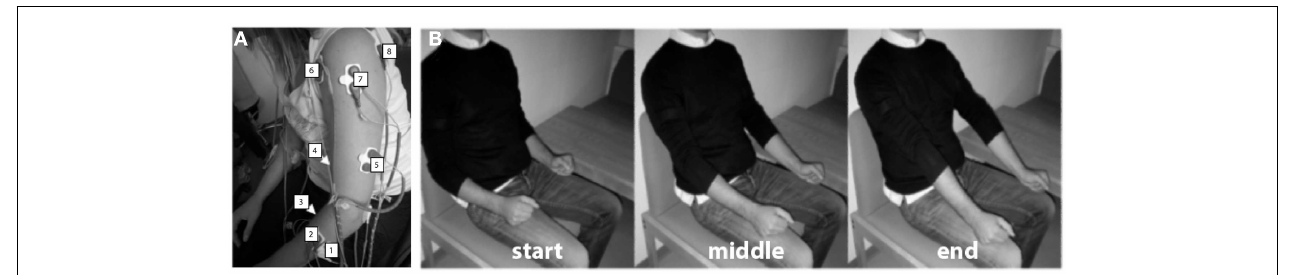
posterior portion of deltoid over the teres minor and infraspinatus muscles. (B) Example of visual instructions illustrating elbow extension.Three different pictures were presented to the patients during the task instruction and execution period, each one representing the starting point of the task [ (B) -left], the intermediate [ (B) -middle], and the end position [ (B)